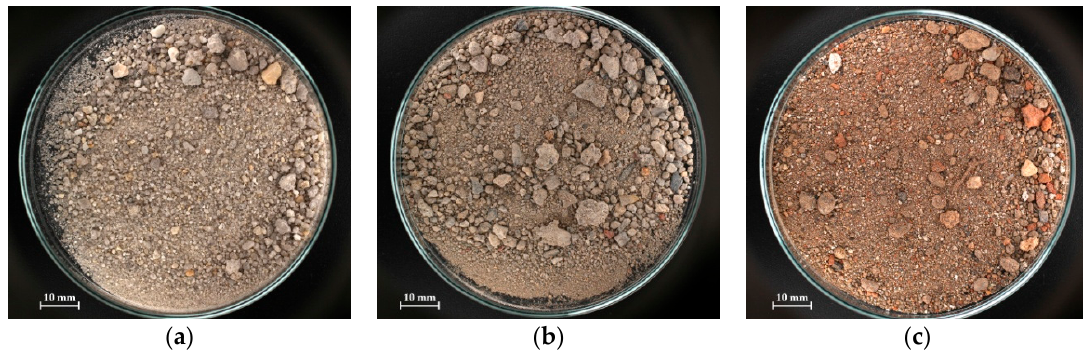
Figure 1. Tested waste materials recycled concrete aggregate (RCA): ( a ) NA; ( b ) RA 1; ( c ) RA 4.